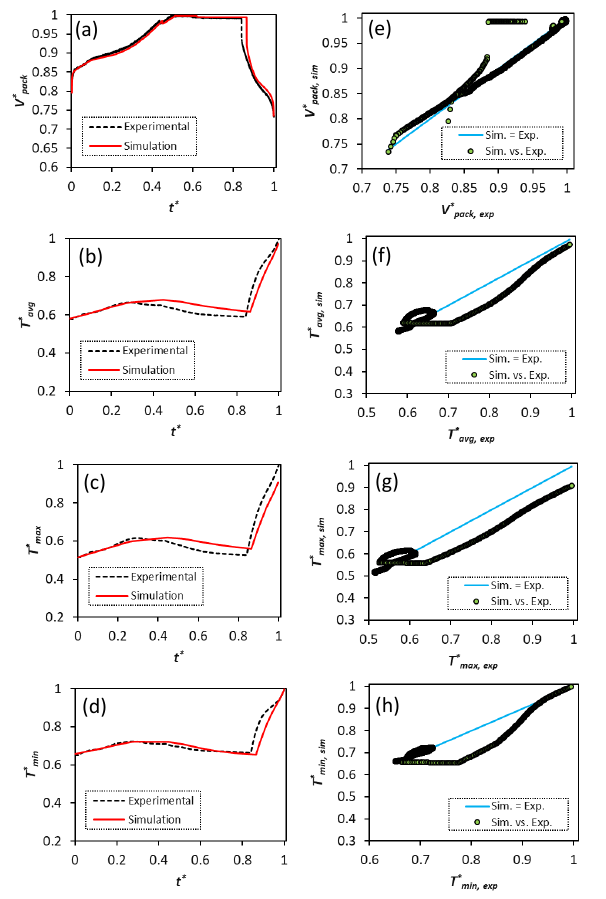
Figure 11. Module-to-module discretization model calibration optimization results for the first scenario (C/2 + C/3 CC charge, CV charge, rest, 1.5 C discharge). ( a ) Pack terminal voltage; ( b ) pack average temperature; ( c ) pack maximum temperature; ( d ) pack minimum temperature; ( e – h ) point by point comparison between the simulations and experiments for the pack terminal voltage, average, maximum, and minimum temperatures within the